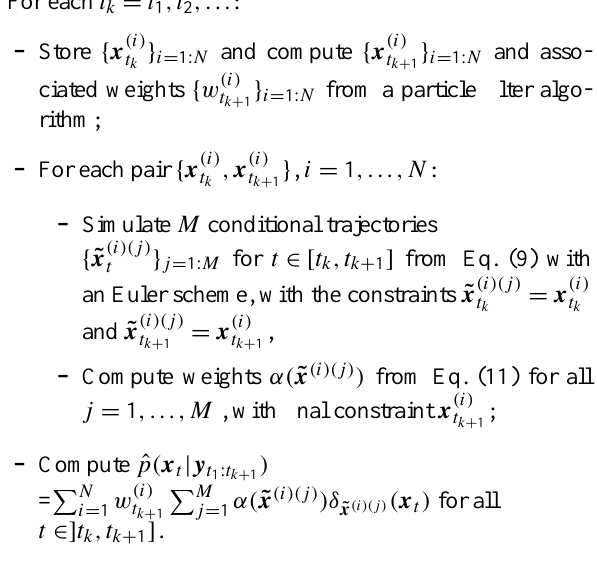
Algorithm 2 Fixed-lag conditional